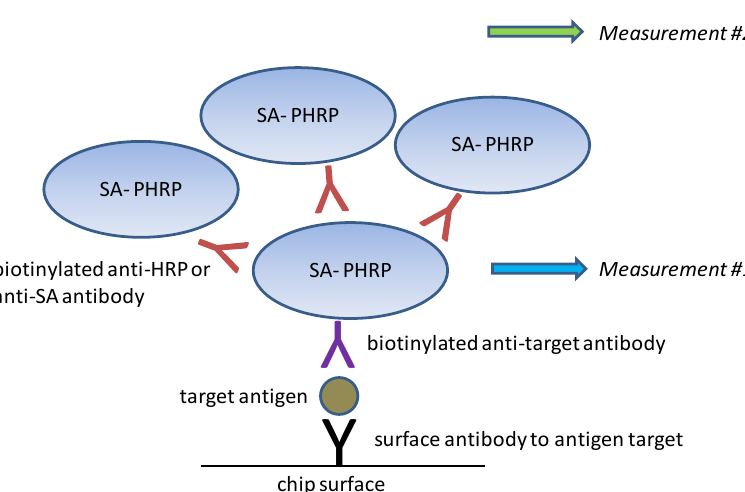
Figure 3. Schematic overview of SABS signal